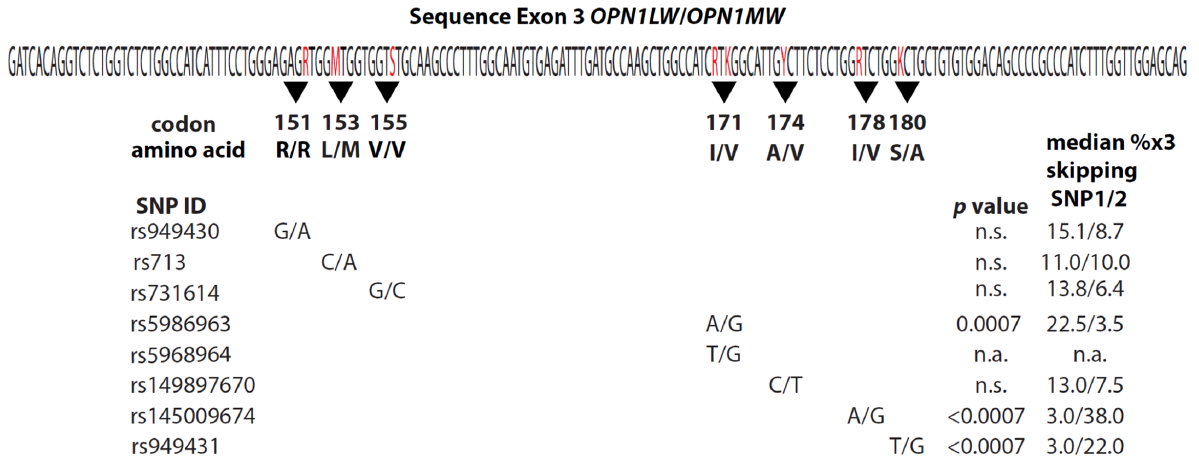
Figure 1. Four of seven exon 3 SNPs differ significantly in exon skipping The nucleotide sequence of OPN1LW/OPN1MW exon 3 is given. The eight polymorphic nucleotides analyzed in this study are shown in red letters using the IUB code where R is A or G, M is A or C, S is G or C, K is G or T, and Y is T or C. Black triangles underscore the codons containing the SNPs and the codon numbers are indicated. More information about each SNP can be found at in dbSNP (https://www.ncbi.nlm.nih.gov/snp/, accessed on 1 February 2022). Below the codon numbers are the two alternate amino acids encoded, below which are the two common nucleotides at each SNP. At each position, the amino acid and nucleotides are given as allele 1/allele 2. For example, codon 151 is either AGG or AGA, designated G/A. Both of these codons encode arginine, designated R/R using the single-letter amino acid code. Codon 153 is either CTG or ATG, designated C/A, and encodes leucine or methionine, respectively, designated L/M (see Table 1 for the single letter amino acid code). SNP ID numbers in the left-most column are from dbSNP151 for the OPN1LW gene. The median percentage of exon-3 skipping for each SNP except the third nucleotide of codon 171 (labeled n.a. for not applicable) is in the right-most column. A slash (/) separates values for alleles 1 and 2. After adjusting for multiple comparisons by applying the Bonferroni correction, three of the SNPs were significantly associated with exon-3 skipping (n.s. indicates adjusted p -value was not significant).